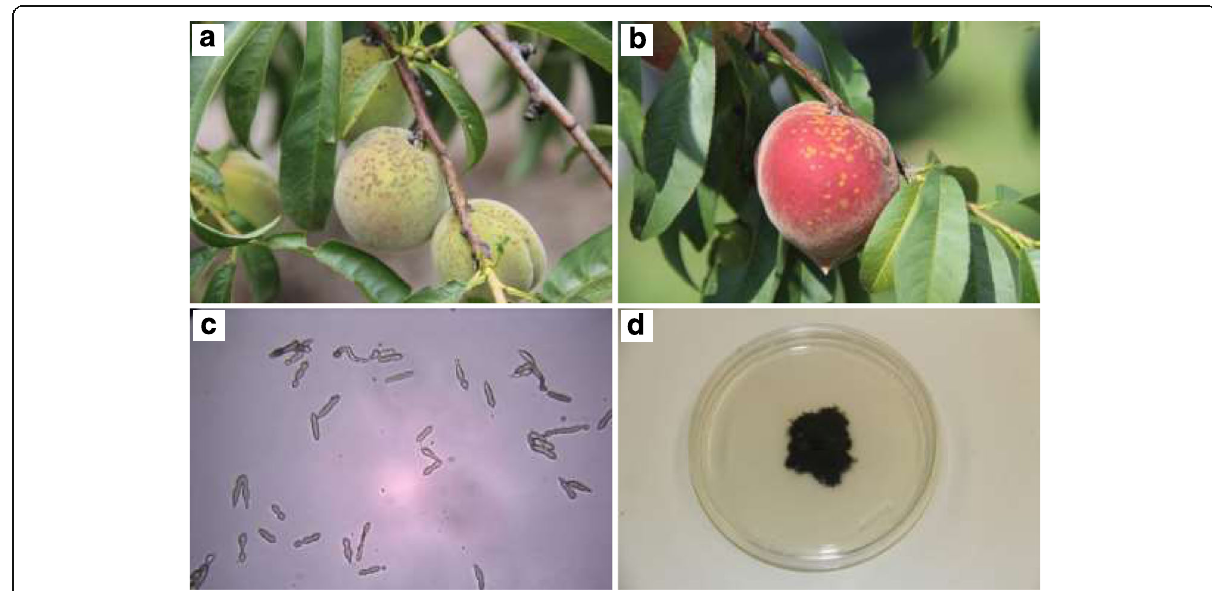
Fig. 1 Scab symptoms caused by Venturia carpophila on a immature peach fruit, b a ripe peach fruit, c conidia of V. carpophila (400×), and d an 8-week old colony of V. carpophila growing on potato dextrose